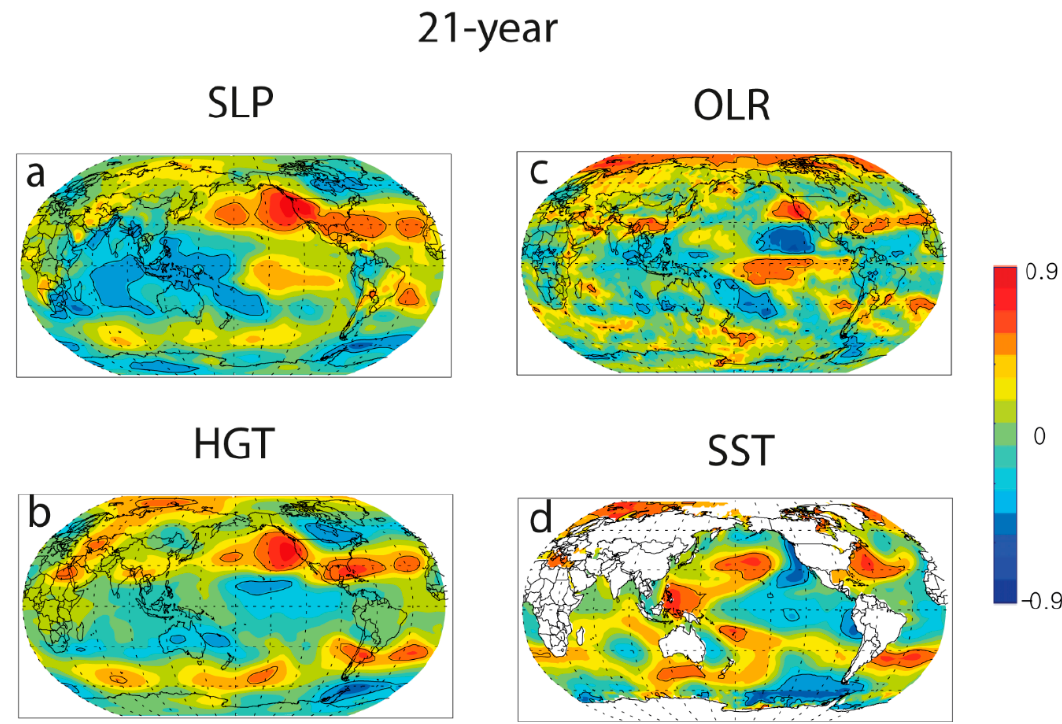
Figure 6. Correlation map of precipitation with ( a ) SLP, ( b ) HGT, ( c ) OLR and ( d ) SST for the 21-year (1995–2015). Correlation coefficients are multiplied by ( − 1.0). Black solid lines indicate significance at the 95% confidence level.